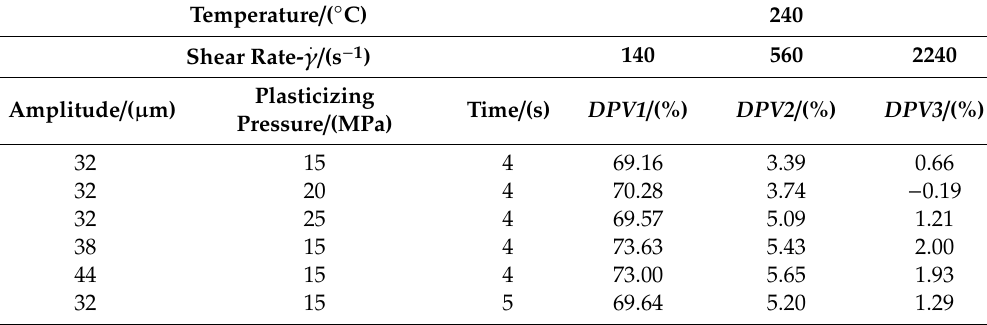
Table 7. Variables involved in MLRA for mode 2 and their